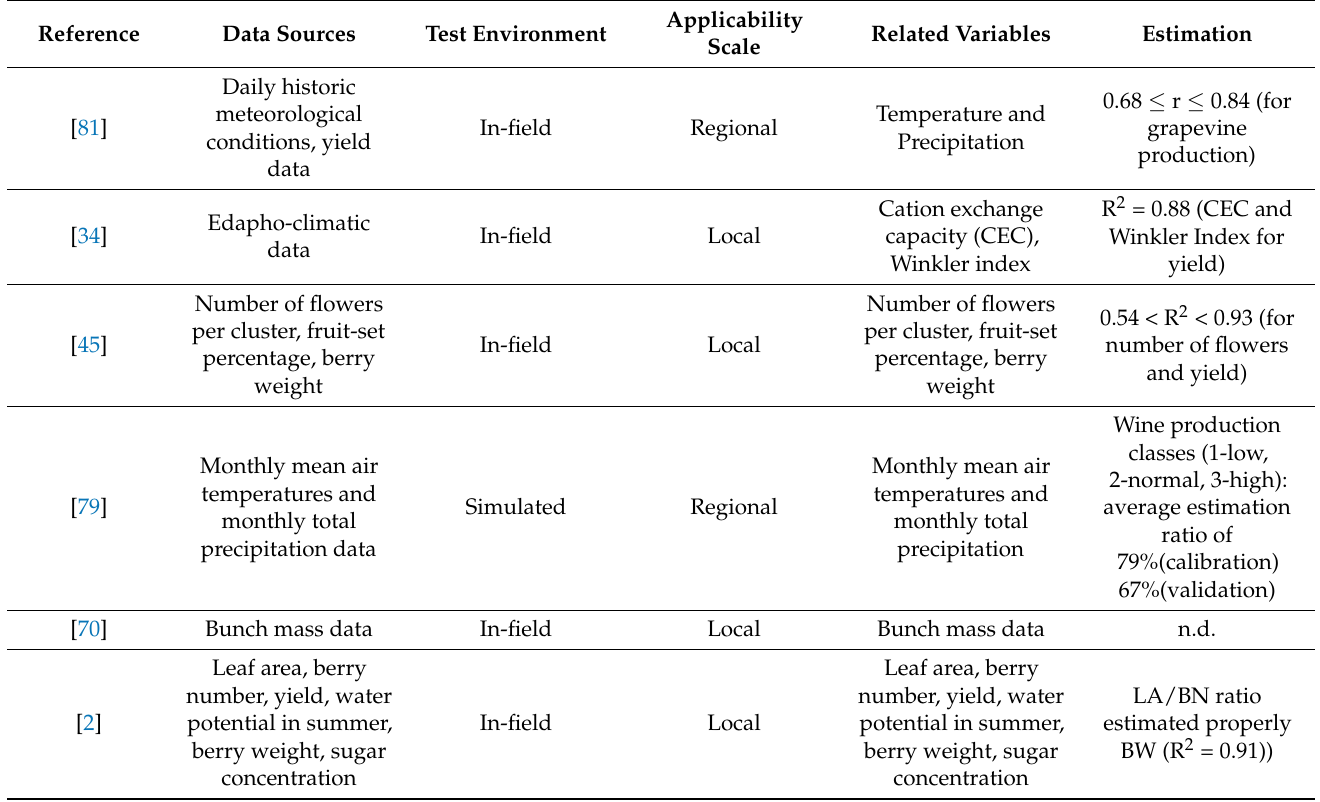
Table 11. Summary of records included in the systematic review (B—other data-driven